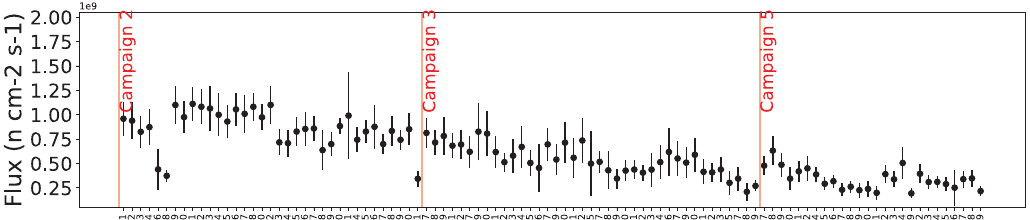
Figure 4: The flux estimates (neutrons cm − 2 s − 1 ) for each experiment based on exponential fits to gamma lines from reference foils in table 1. Campaign 4 yielded no conclusive fits for flux estimates and are